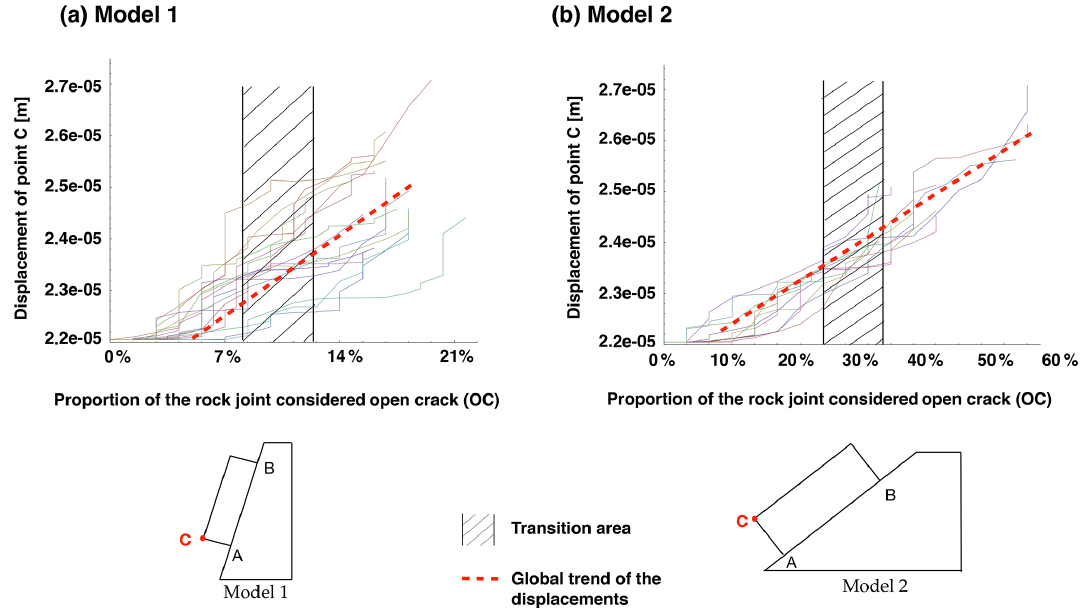
Figure 7. Displacement of point C (in metres) with respect to the proportion of OC contacts along the joint, for models 1 and 2 considering Scenario 3. The transition zone presented here corresponds to the one defined previously (Sect. 3.2).